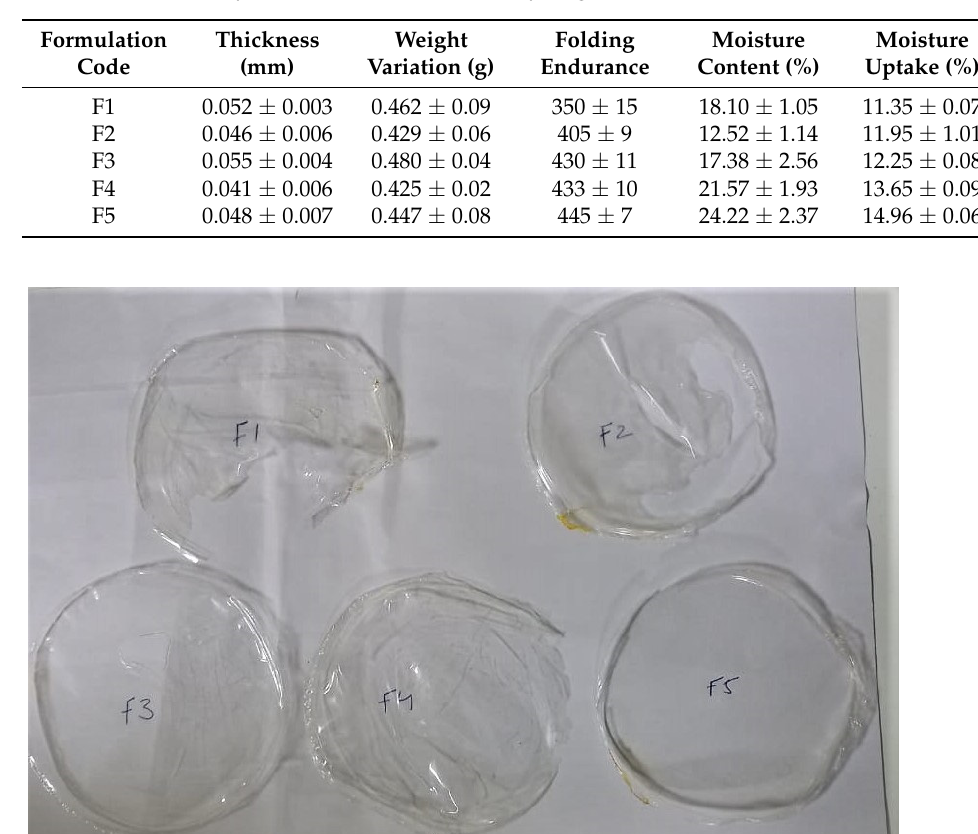
Table 1. Results of Physicochemical evaluation of hydrogel films. ( n = 3).